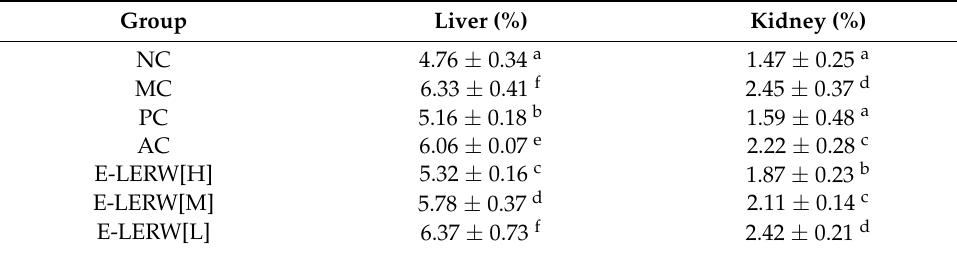
Table 4. The effect of astilbin and E-LERW on the organ indexes of diabetic mice.